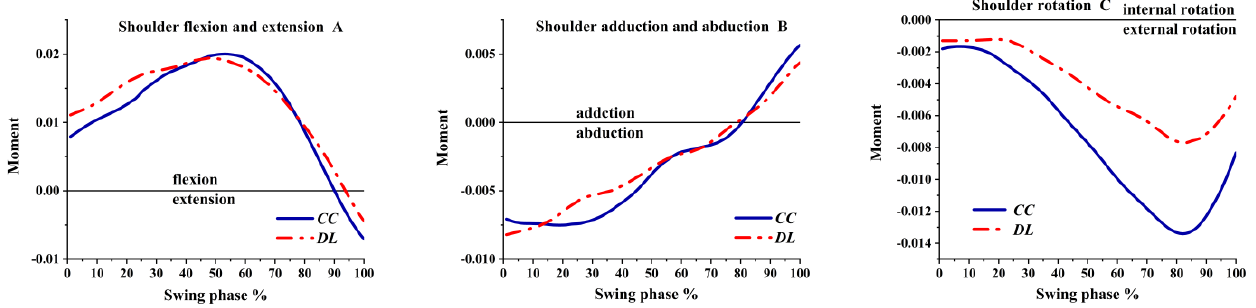
Figure 13. The moment of shoulder joint during swing phase.